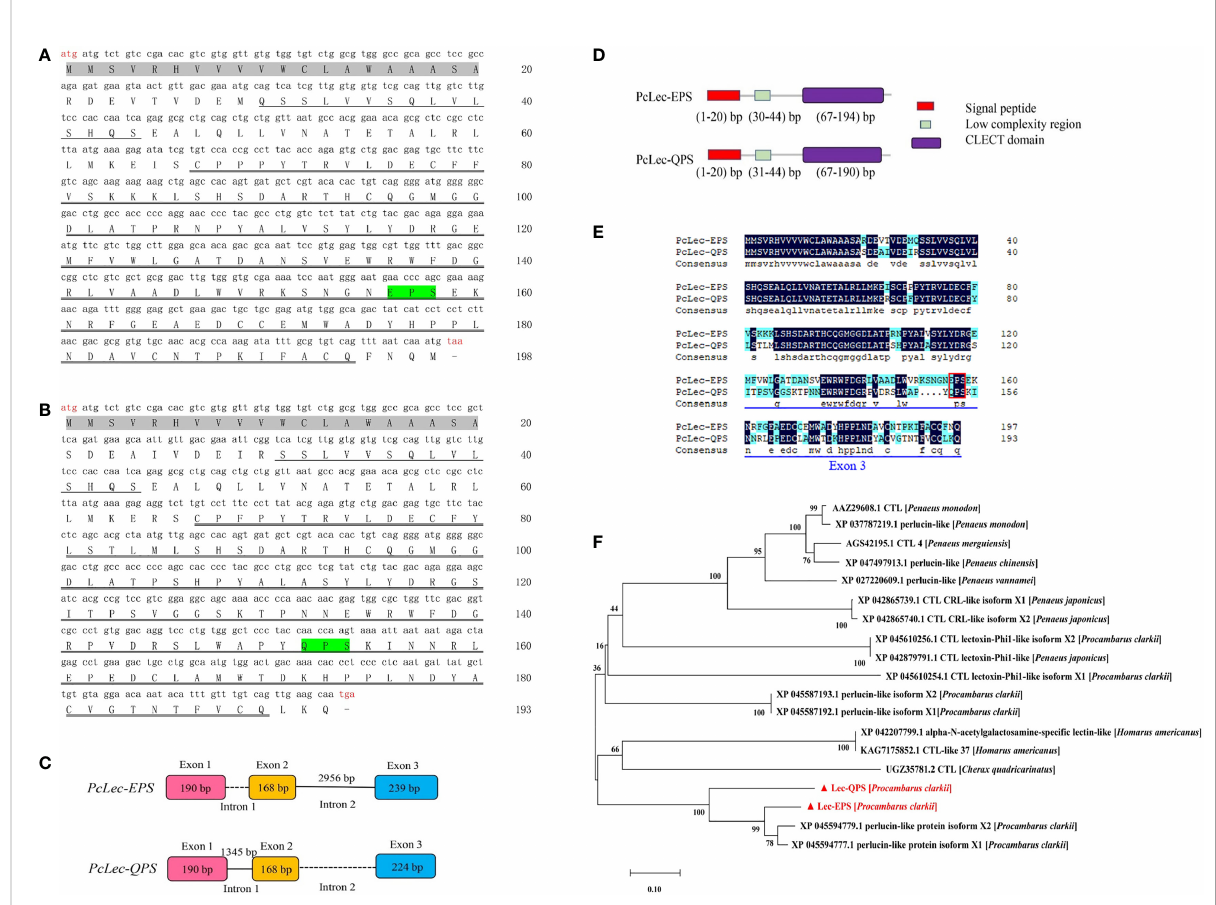
FIGURE 1 (A) Nucleotide sequence and deduced amino acid sequence of PcLec-EPS. (B) Nucleotide sequence and deduced amino acid sequence of PcLec-QPS. The start codon (atg) and stop codon (taa/tga) are marked in red. The signal peptide, low complexity region, and CLECT/CRD domain are marked with gray shadow, single underline and double underline, respectively. (C) Genomic structure of PcLec-EPS and PcLec-QPS . Exons, known intron, and unknown intron are represented by boxes with different color, straight line, and dotted line, respectively. The number in the boxes and above the straight line represent the number of nucleotides. (D) Protein structures of PcLec-EPS and PcLec-QPS. The signal peptide, low-complexity region, and CLECT/CRD domain are respectively marked in red, green, and purple boxes. The range of the nucleotide encoding the amino acids of each domain is provided. (E) The amino acids sequence alignment of PcLec-EPS and PcLec-QPS. The identical and similar amino acid residues were shaded in black and blue, respectively. The EPS and QPS are marked in red box. The difference in amino acids between PcLec-EPS and PcLec-QPS that underlined in blue is major caused by the difference of exon 3 sequence. (F) Phylogenetic analysis of PcLec-EPS, PcLec-QPS, and their homologous proteins from crustaceans was performed by MEGA 7.0. PcLec-EPS and PcLec-QPS are marked in red with triangle. The phylogenetic tree was built by the NJ algorithm, and the numbers at the nodes indicated the bootstrap